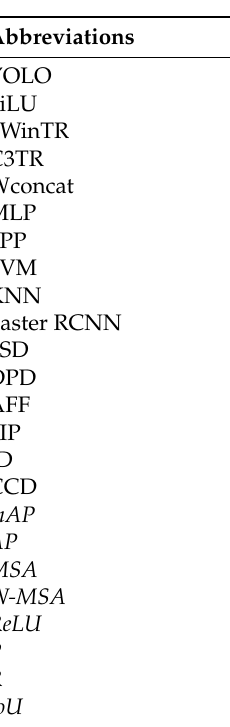
Table 1. List of main